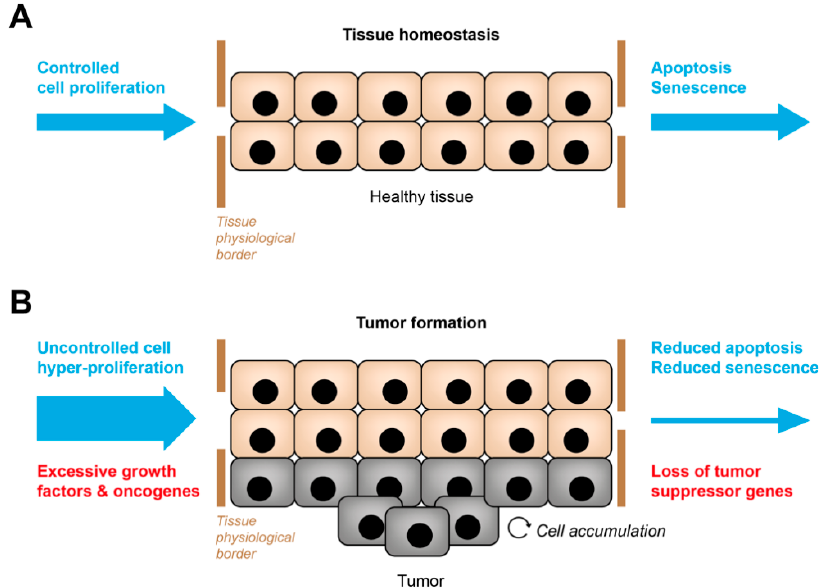
Figure 1. Deranged tissue homeostasis in hyperplastic tumors. ( A ) Under physiological conditions, the size of a specialized tissue is kept constant (beige cells). Tissue homeostasis is a steady state where tissue generation by cell proliferation (blue arrow on the left) and clearance of damaged or old cells by apoptosis or cellular senescence (blue arrow on the right) are kept in balance. ( B ) High levels of growth factors or the activation of oncogenes lead to hyperproliferation (enlarged blue arrow on the left), and loss of tumor suppressors cause reduced apoptosis or cellular senescence (narrowed blue arrow on the right). This dysfunctional tissue homeostasis evokes excessive tissue formation and hyperplastic tumor growth (grey cells).